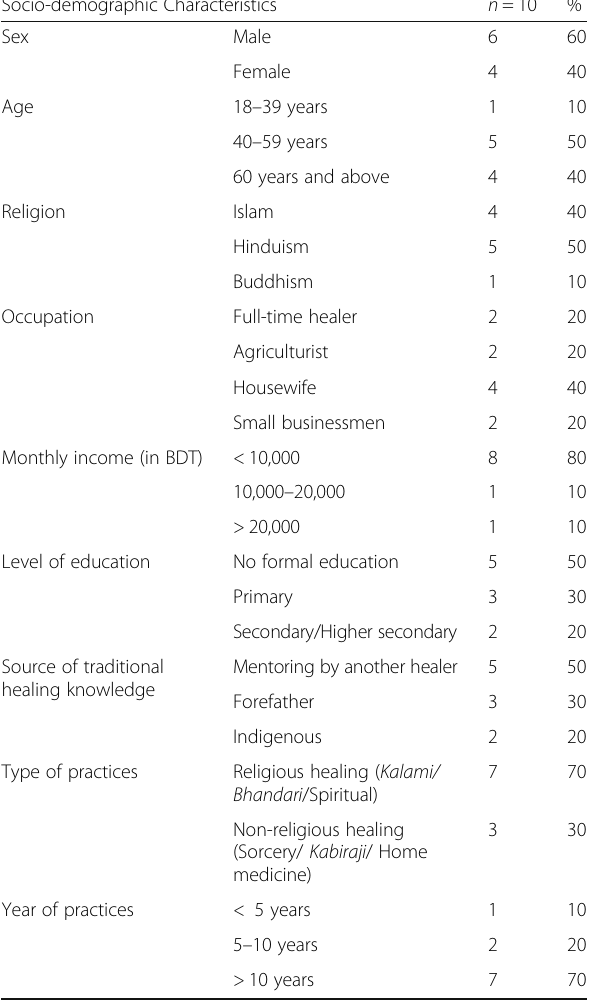
Table 2 Socio-demographic characteristics of traditional healers ) Socio-demographic Characteristics